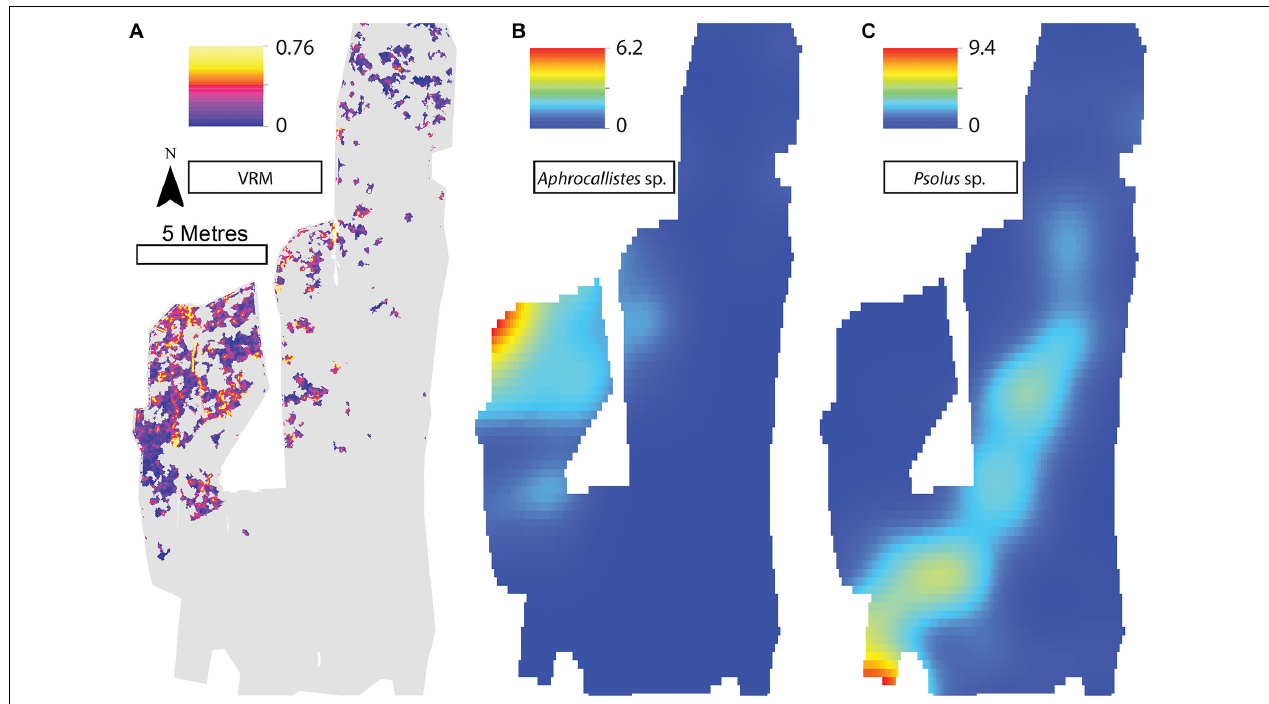
FIGURE 9 | (A) Vector Ruggedness Measure values for reef facies. Kernel estimate of intensity plots (number of individuals per m 2 and sigma = 1) (B) Aphrocallistes sp., (C) Psolus sp. for Site C. Note varying colour scale between the different